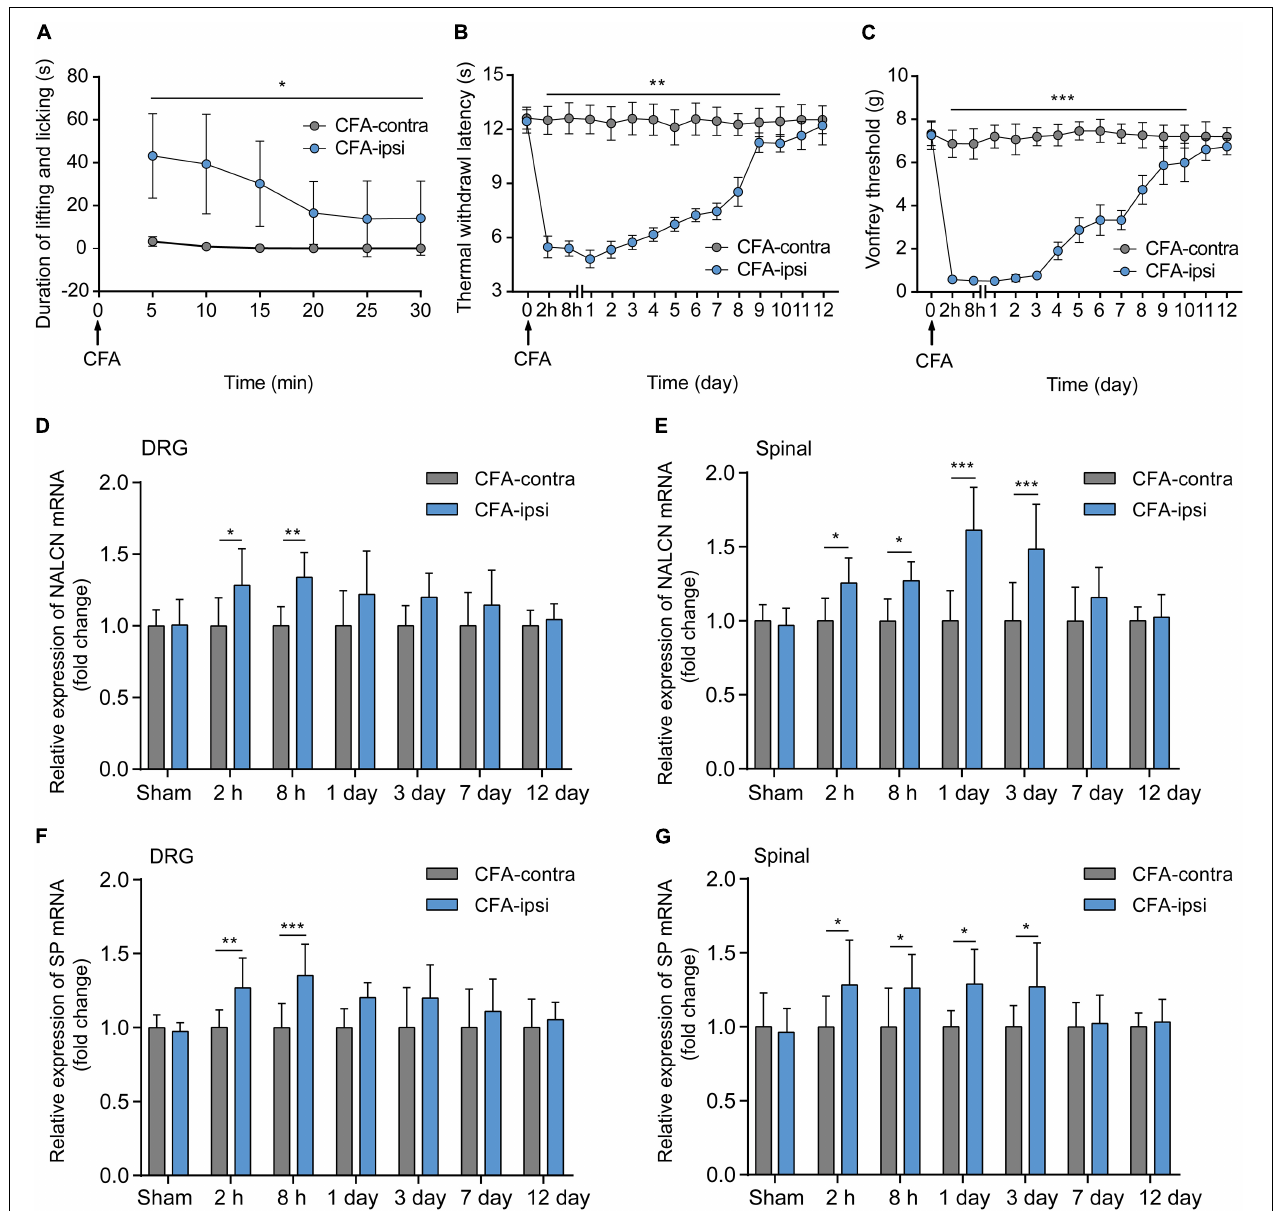
FIGURE 1 | Relative expression of sodium leak channel (NALCN) and substance P (SP) increase after injection of CFA. (A) Time course of spontaneous pain behavior (lifting/licking/flinching behaviors), following CFA injection ( n = 10, by two-way repeated measures ANOVA, Holm–Sidak test). (B) Time course of thermal hyperalgesia following CFA injection ( n = 10, by two-way repeated measures ANOVA, Holm–Sidak test). (C) Time course of mechanical allodynia, following CFA injection ( n = 10, by two-way repeated measures ANOVA, Holm–Sidak test). (D) Changes in NALCN mRNA level in DRG ( n = 10, by two-way ANOVA, Holm–Sidak test). (E) Changes in NALCN mRNA in spinal dorsal horn ( n = 10, by two-way ANOVA, Holm–Sidak test). (F) Changes in SP mRNA in DRG ( n = 10, by two-way ANOVA, Holm–Sidak test). (G) Changes in SP mRNA expression in spinal dorsal horn ( n = 10, by two-way ANOVA, Holm–Sidak test). CFA-contra: CFA-contralateral side; CFA-ipsi: CFA-ipsilateral side; DRG: dorsal root ganglion; SP: substance P. Data are presented as mean ± SD. * p < 0.05, ** p < 0.01, *** p < 0.001.